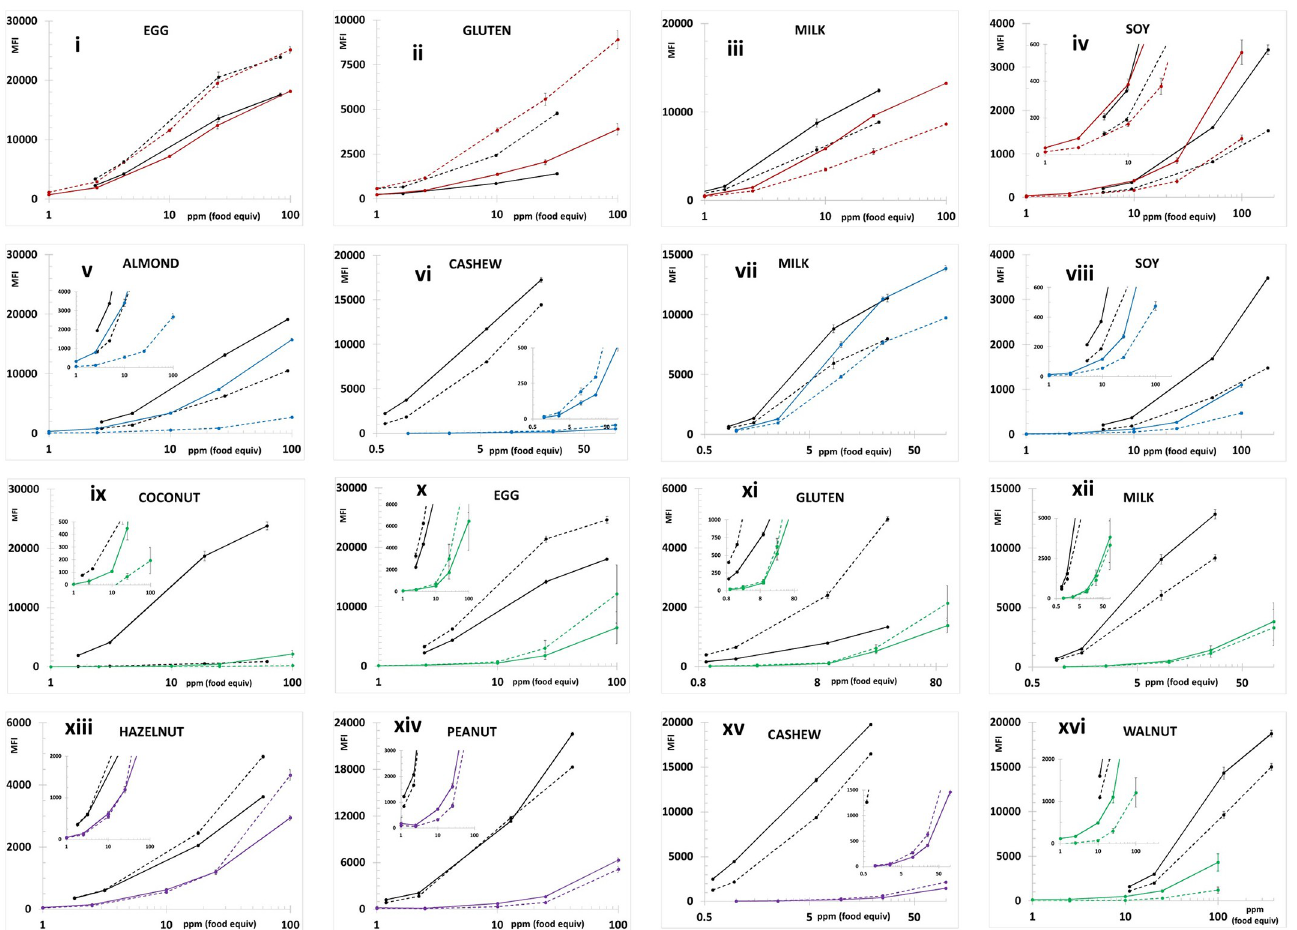
Fig 5. Average MFI of bead sets generating MFI with incurred food samples by Lab 01. Same as Fig 4 except the average of only the triplicate analyses generated by Lab 01. standards (black solid line > black dashed line) to cashew-18 � cashew-19 for the orange juice and dark chocolate samples (colored solid line � colored dashed line).